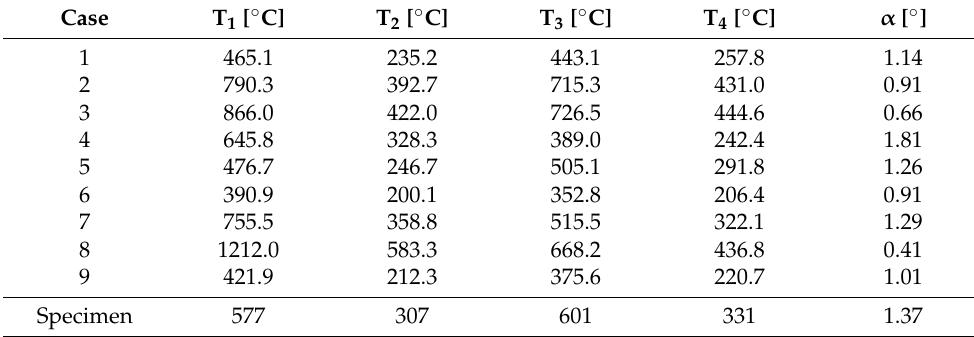
tion of the thermocouples: T 1 and T 2 are closer to the bottom of the heat cone than T 3 and